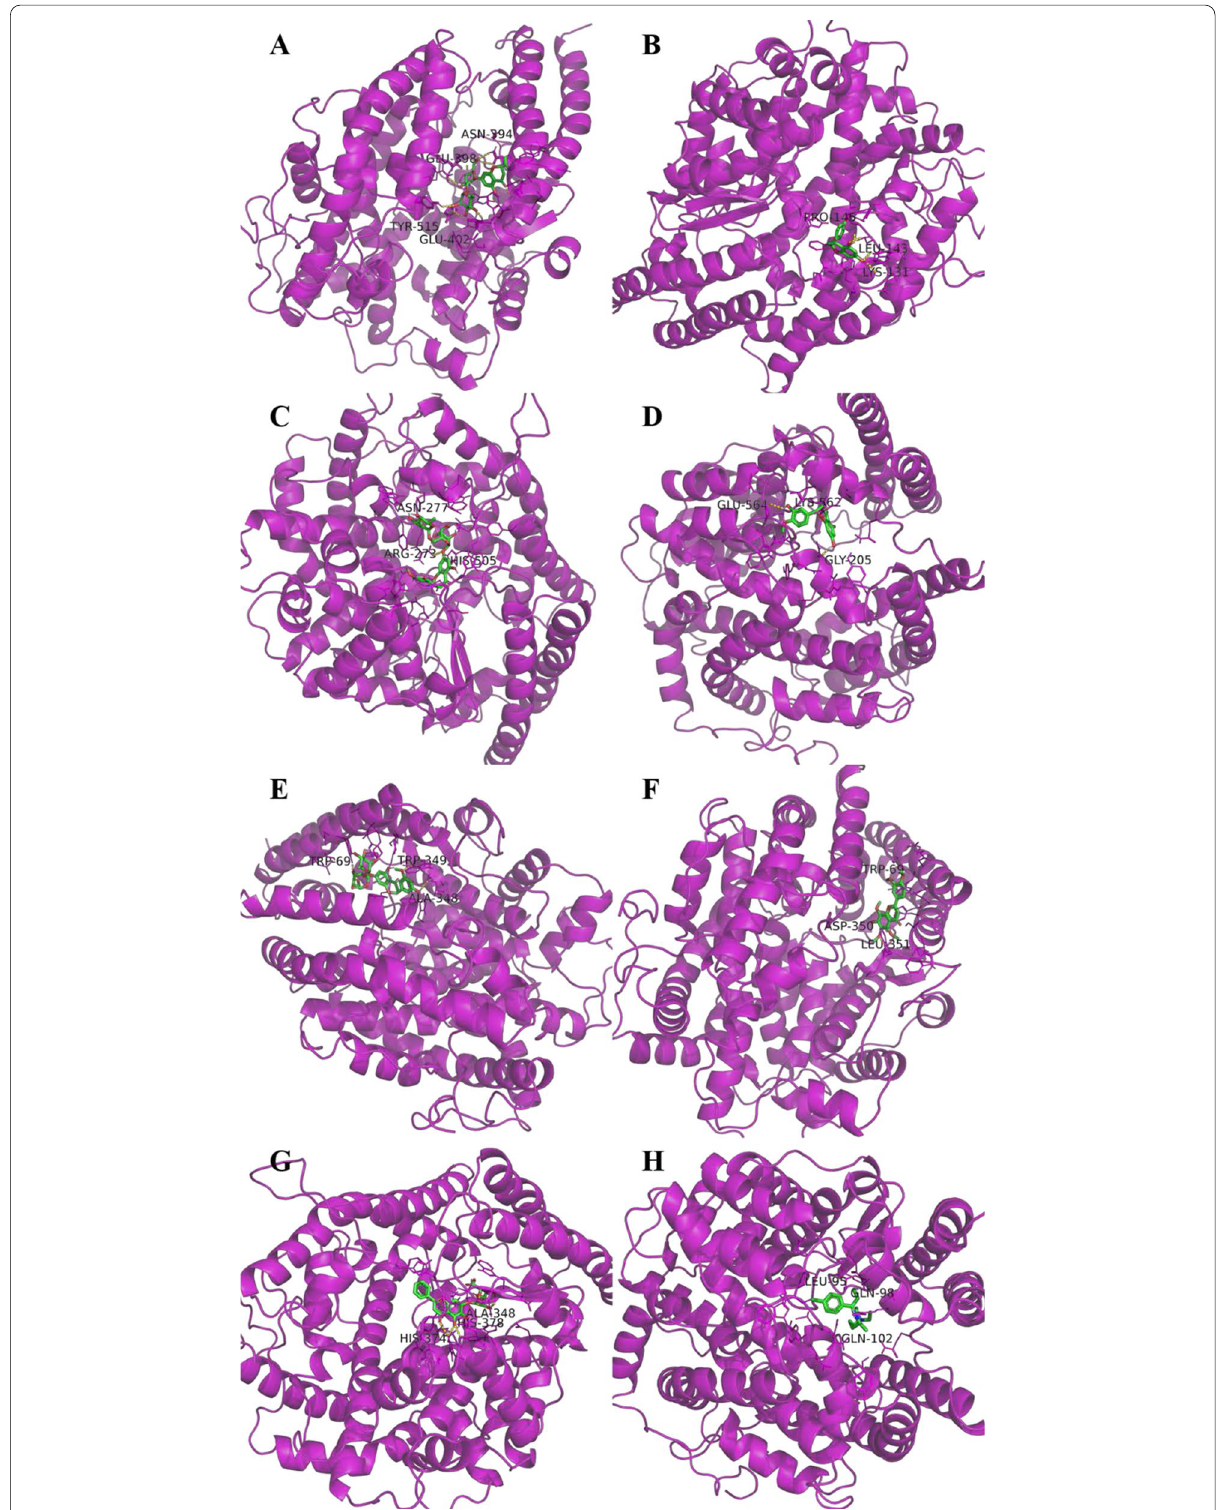
Fig. 4 Molecular docking results of naringin ( A ), naringenin ( B ), hesperidin ( C ), hesperetin ( D ), neohesperidin ( E ), nobiletin ( F ), baicalin ( G ), and glycyrrhizin ( H ) to ACE2 enzyme (PDB code: 6ACG). The AutoDock 4.2 software was selected for the docking study using a hybrid Lamarckian Genetic Algorithm